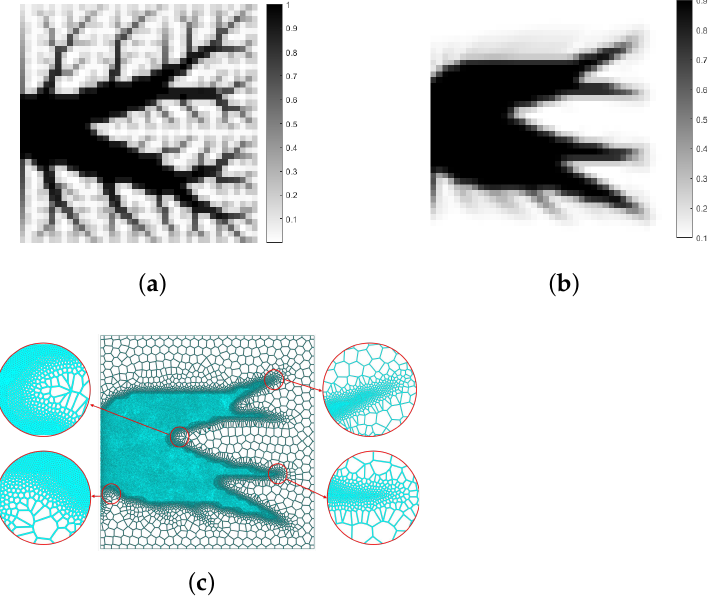
Figure 9. Results of gradient distributed heating: ( a ) the relative density distribution obtained by the SIMP method; ( b ) the relative density distribution obtained by the proposed multiscale method; ( c ) the reconstructed Voronoi-GSCS.